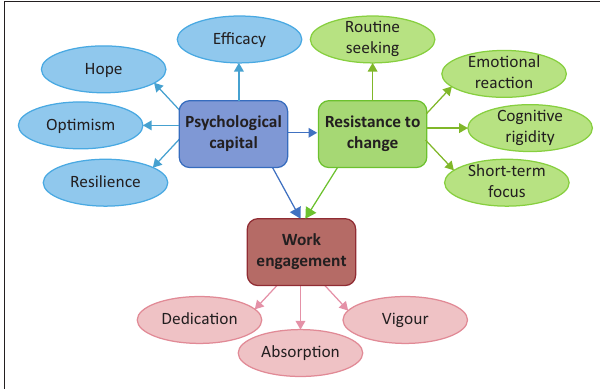
FIGURE 1: Preliminary conceptual model encapsulating research hypothesis